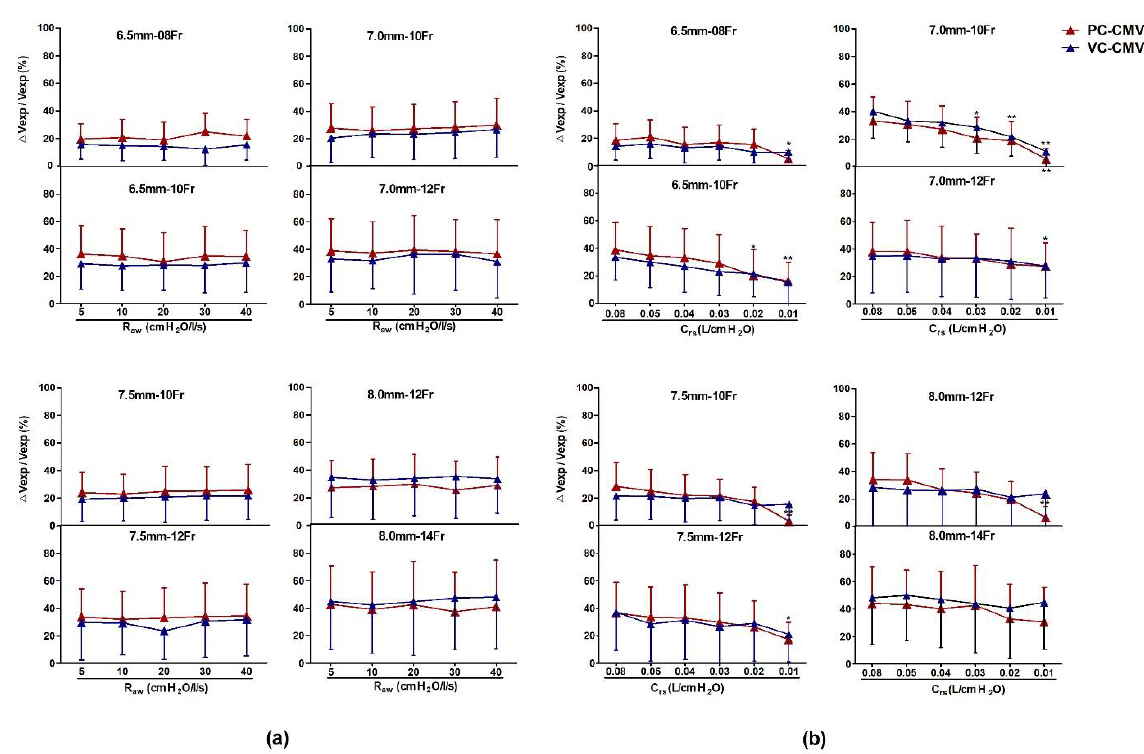
Figure 6. Comparison of △ Vexp/Vexp% effects in different respiratory systems and ventilation modes. Various ETTs paired with SCs for CSS conducted endotracheal suctioning in airway resistance pulmonary mechanics for the obstructive system ( a ) and lung compliance pulmonary mechanics for the restrictive system ( b ) with VC-CMV or PC-CMV. ( △ ) Vexp: (delta) expiratory minute volume (baseline Vexp level substrates with suctioning Vexp level); △ Vexp/Vexp%: percentage of baseline Vexp level divided by △ Vexp; PC-CMV: pressure control continuous mandatory ventilation, this mode set inspiratory pressure at 20 cm H 2 O with inspiratory time at 1 s; VC-CMV: volume control continuous mandatory ventilation, this mode is set to V T 0.6 L with peak flow 60 Lpm; R aw : airway resistance; C rs : lung compliance; ETT: endotracheal tube; SC: suction catheter; 6.5 mm − 08 Fr: 6.5 mm ETT paired with 08 Fr SC, and so on. The independent samples t -test was used to compare with 5 cm H 2 O ･ L −1 ･ s of R aw and 0.08 L ･ cm H 2 O −1 of C rs group. * p < 0.05, ** p < 0.01.